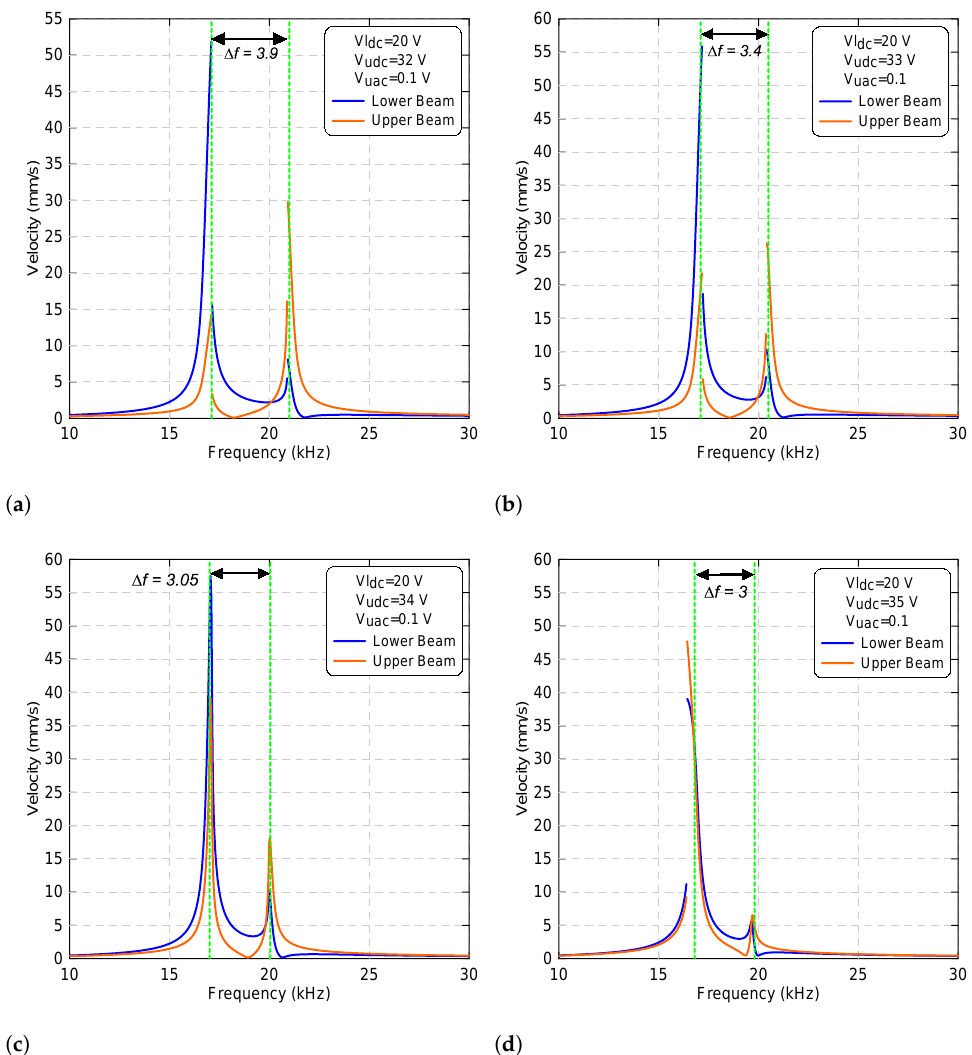
Figure 12. The frequency-response curves of the lower beam resonance frequency f l 1 and of the upper beam resonance frequency f u 1 with a lower voltage sets to V ldc = 20 V and a upper voltage sets to: ( a ) V udc = 32 V, ( b ) V udc = 33 V, ( c ) V udc = 34 V and ( d ) V udc = 35 V. The upper harmonic voltage V uac is set to 0.1 V. The lower beam results are marked with blue lines and the upper beam results are marked with orange